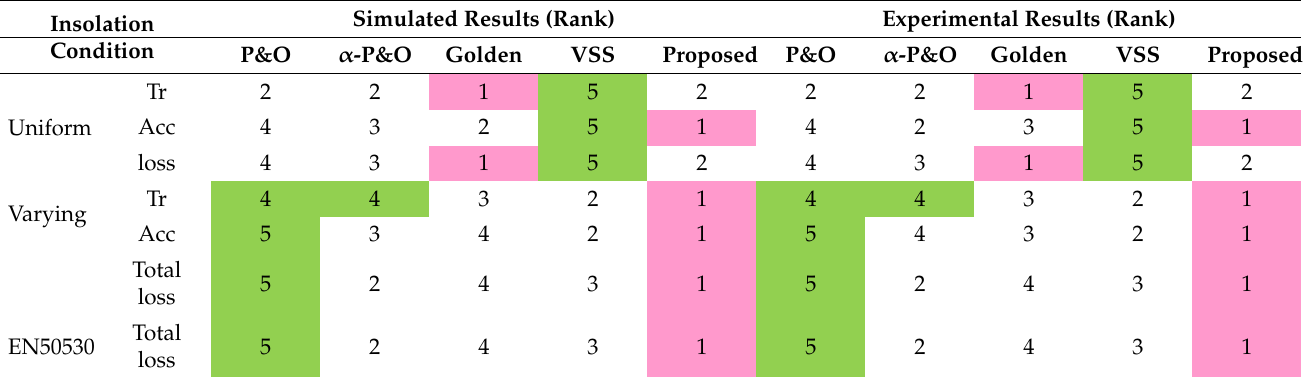
Table 9. Rank of the performance indices of the simulated and experimental results for the five compared